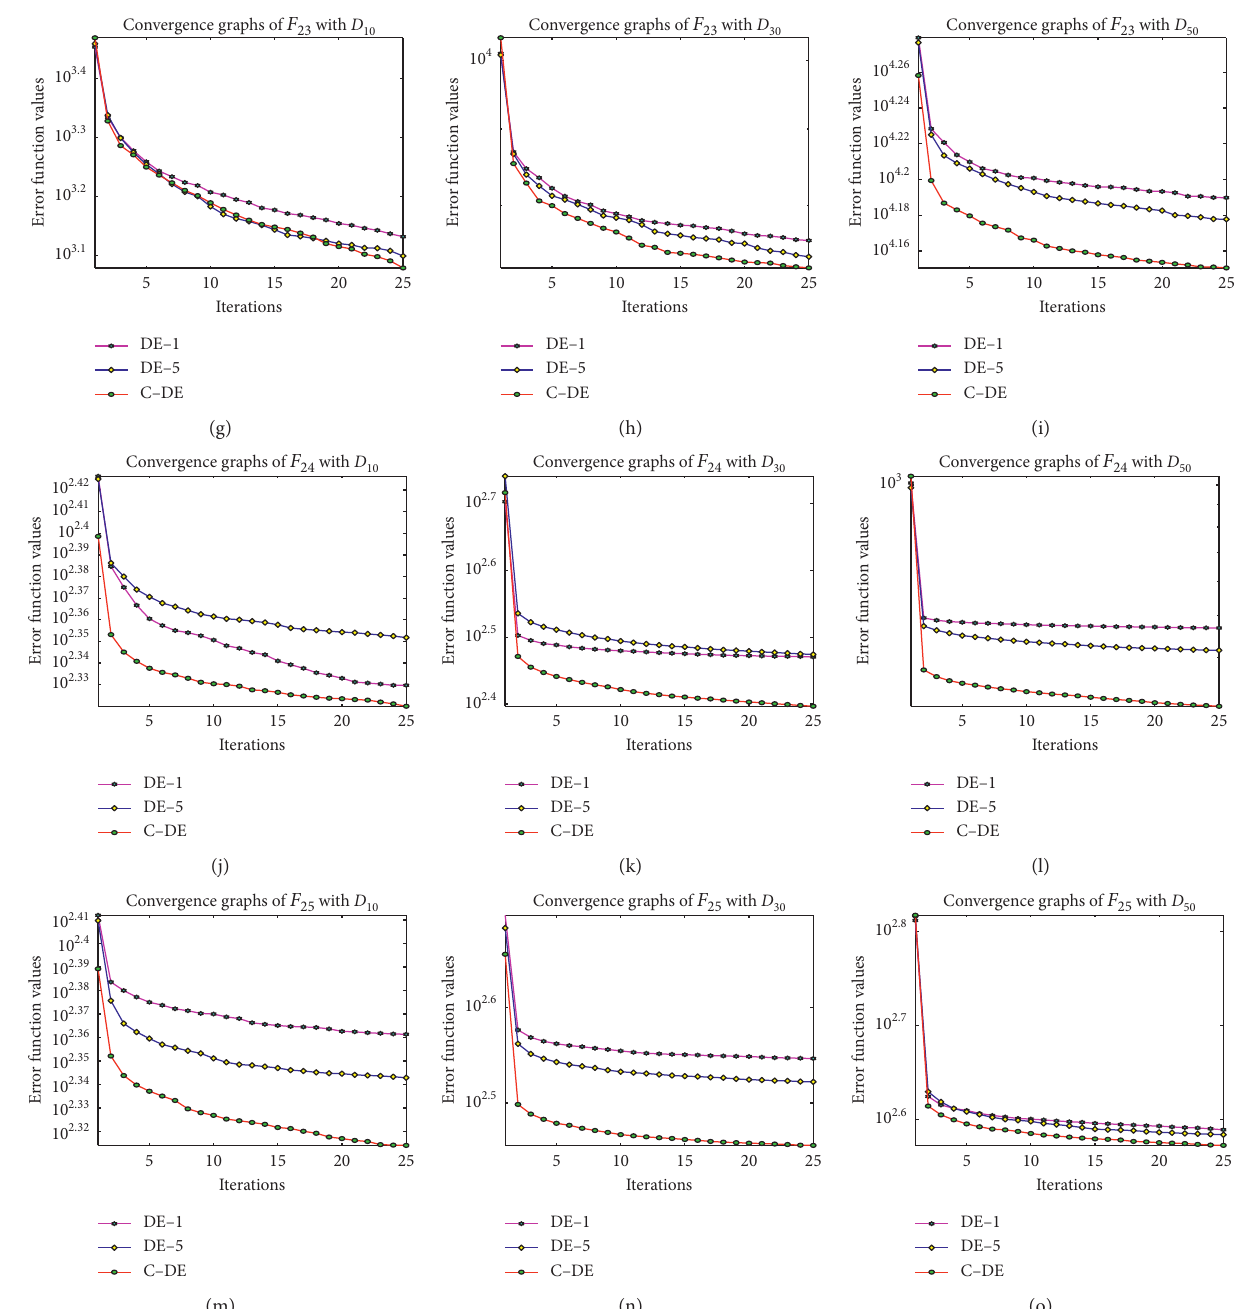
Figure 6: Evolution in the best function values of F